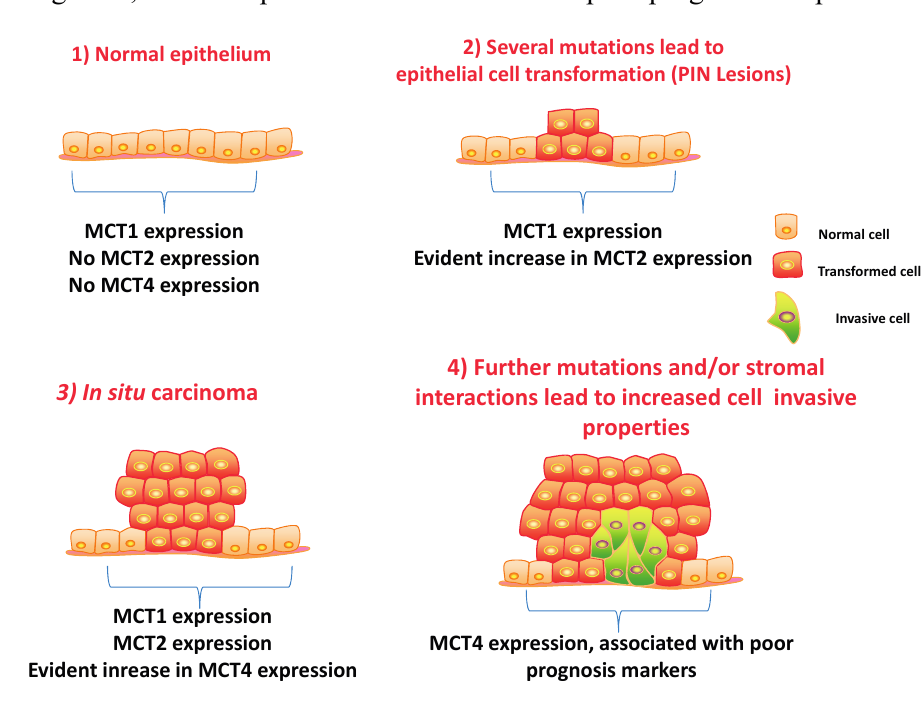
Figure 1. Schematic representation of the different stages of prostate cancer (PCa) tumour initiation and progression. Monocarboxylate transporter 1 (MCT1) is expressed in both non-neoplastic and malignant glands, whereas MCT2 is increased from benign to prostate intraepithelial neoplasia (PIN) lesions and malignant glands. MCT4 is only expressed in malignant glands, and its expression is associated with poor prognosis for